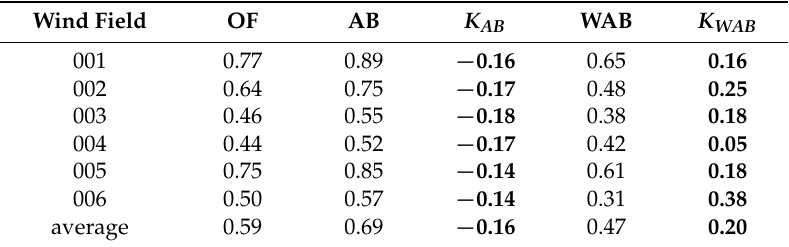
Table 4. Standard deviation bias (m/s) and change rate K (%) of three outputs of ensemble average forecasts.